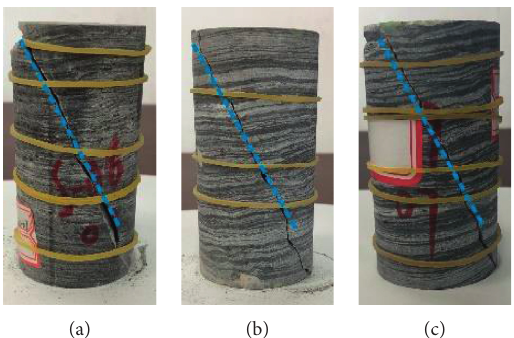
Figure 12: Failure modes of dry phyllite ( σ and (c) σ 3 � 20MPa, α � 61 ° .